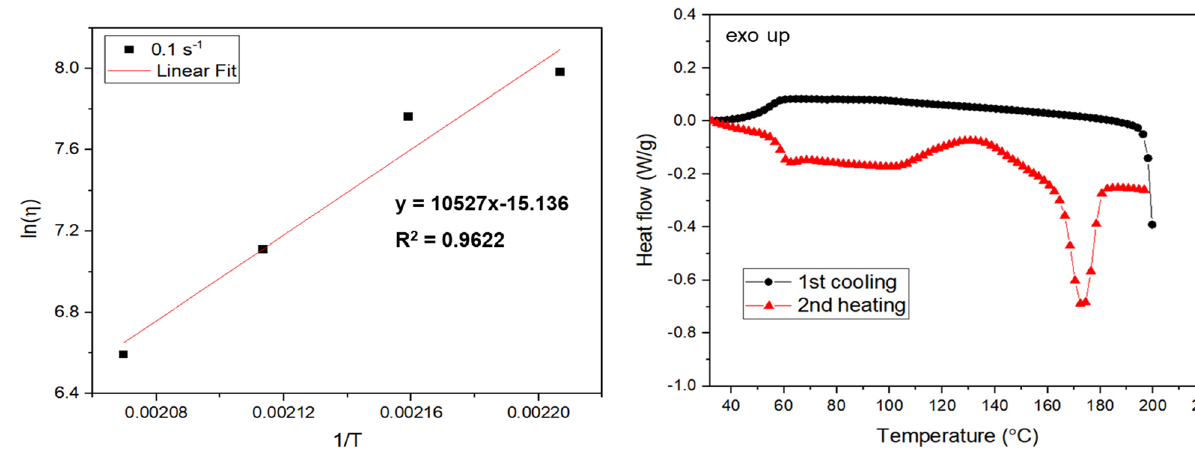
Figure 4: Plot of ln ( viscosity ) versus 1/ T for the PLA at 0.1/s shear rate.